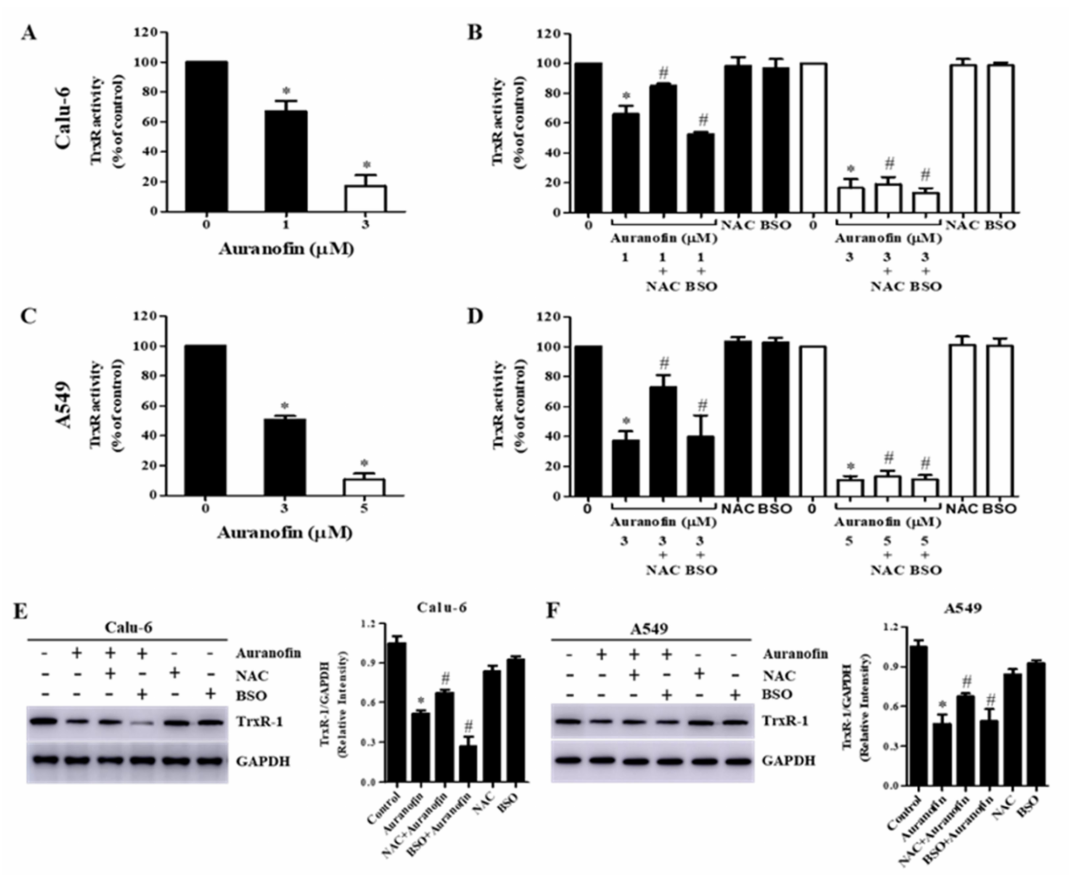
Figure 8. Effects of NAC and BSO on TrxR activity in auranofin-treated Calu-6 and A549 cells. Exponentially growing Calu-6 cells or A549 cells were incubated in the presence of the indicated concentrations of auranofin for 24 h following 1 h pre-incubation with 2 mM NAC or 10 µ M BSO. TrxR activity was measured using the insulin reduction assay. ( A – D ): The graphs indicate the inhibition of TrxR activity by auranofin or combination treatment with NAC or BSO in Calu-6 cells ( A , B ) and A549 cells ( C , D ). E and F: Whole-cell extracts were prepared, and equal amounts of lysates were then resolved through SDS-PAGE, transferred onto PVDF membranes, and immunoblotted with TrxR-1 antibody. GAPDH detection was used to confirm equal protein loading. Graphs show ratio of TrxR-1/GAPDH by auranofin or combination treatment with NAC or BSO in Calu-6 cells ( E ) and A549 cells ( F ), and band intensities were quantified using the Image J program. * p < 0.05 compared with auranofin-untreated control cells. # p < 0.05 compared with cells treated with auranofin